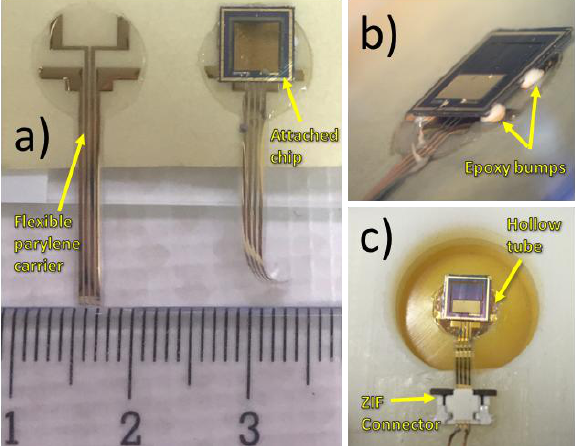
Figure 3. ( a ) Flexible parylene carrier before and after chip attachment; ( b ) Side view of the attached chip with epoxy bumps; ( c ) Chip and carrier placed on the vibrating membrane on hollow tube. Electrical connections are made with a zero-insertion-force (ZIF)